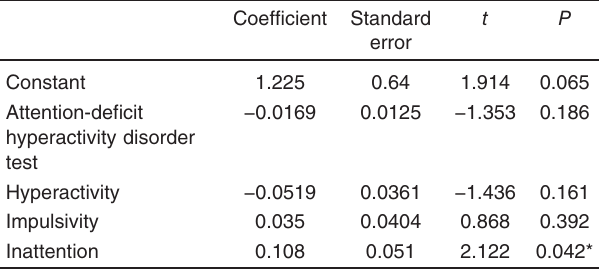
Table 6 The effect of parental interaction on attention-deficit hyperactivity disorder quotient and subscales of attention- deficit hyperactivity disorder test: hyperactivity, impulsivity, and